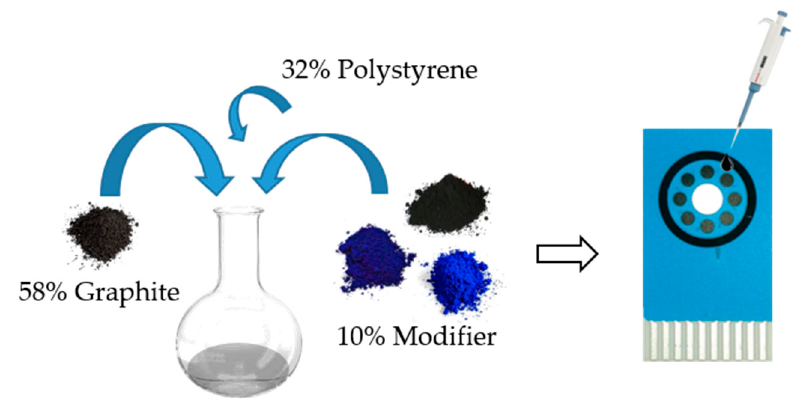
Figure 2. Scheme of the experimental procedure for the electrode surface modification. Firstly, an ink-like solution was prepared incorporating the corresponding modifier. Then, 5 µL was dropped on the electrode surface and dried a 40 °C. An activation step is done with hydrogen peroxide to finally record the voltammetric signal.